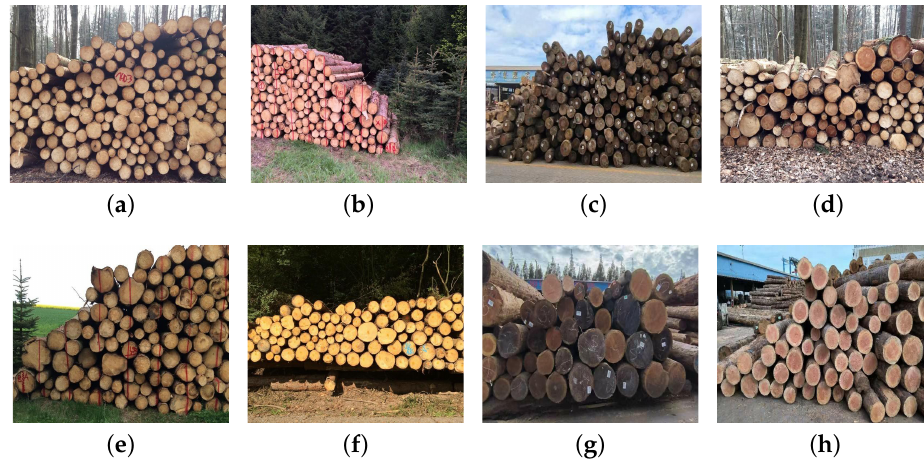
Figure 1. Wood log images in different environment. ( a , e ). Different backgrounds. (b , f ). Different shooting angles. ( c , g ). Different color textures. ( d , h ). Different